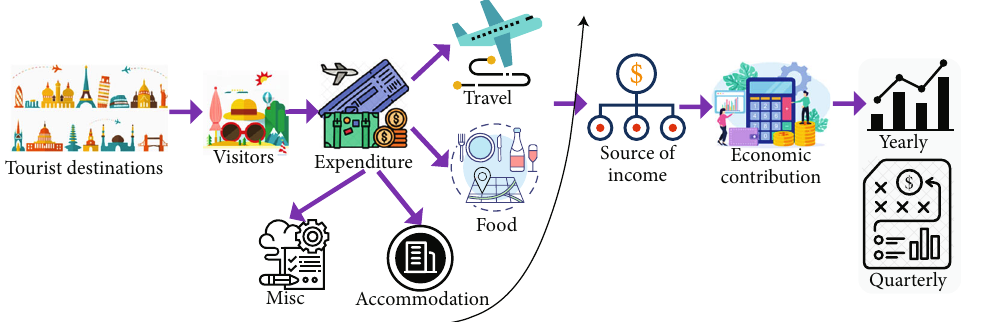
Figure 6: Tourist expenditure and economic contribution.